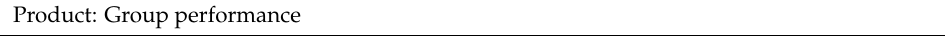
Table 3. Theories commonly used in the study of collaborative